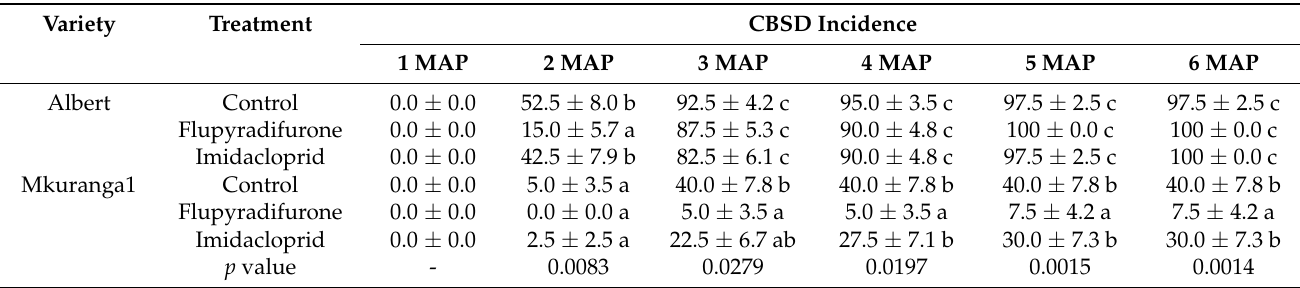
Table 8. Cassava brown streak disease (CBSD) percentage incidence for cutting dipping method, 2020 (Means ± SE) Z .